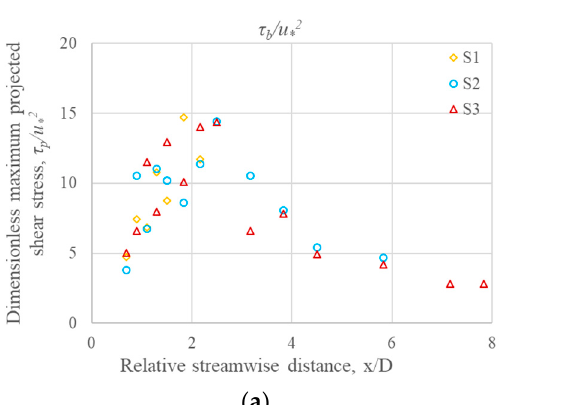
Figure 7. Vertical profiles of dimensionless resultant Reynolds shear stress ( τ p /u * 2 ) in the symmetry plane for the 3 experimental scenarios S1, S2, and S3, combining both midstream and downstream.